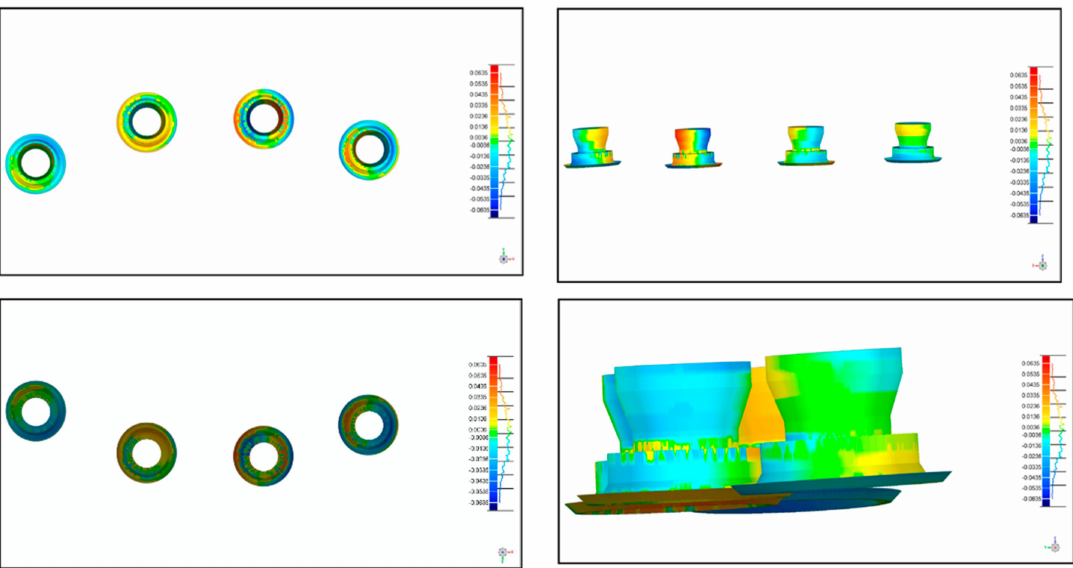
Figure 4. STL files overlapped using the Geomagic software (Geomagic Qualify 12, 3D Systems, Rock Hill, SC, USA), facilitating the calculation of three-dimensional (3D) deviations between the master model data and the different